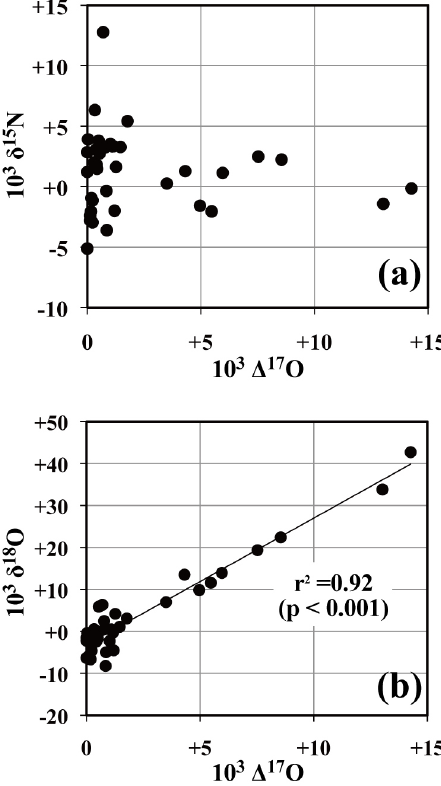
Figure 4. Relationship between 1 17 O and δ 15 N of nitrate (a) and 1 17 O and δ 18 O of nitrate (b) in stream water